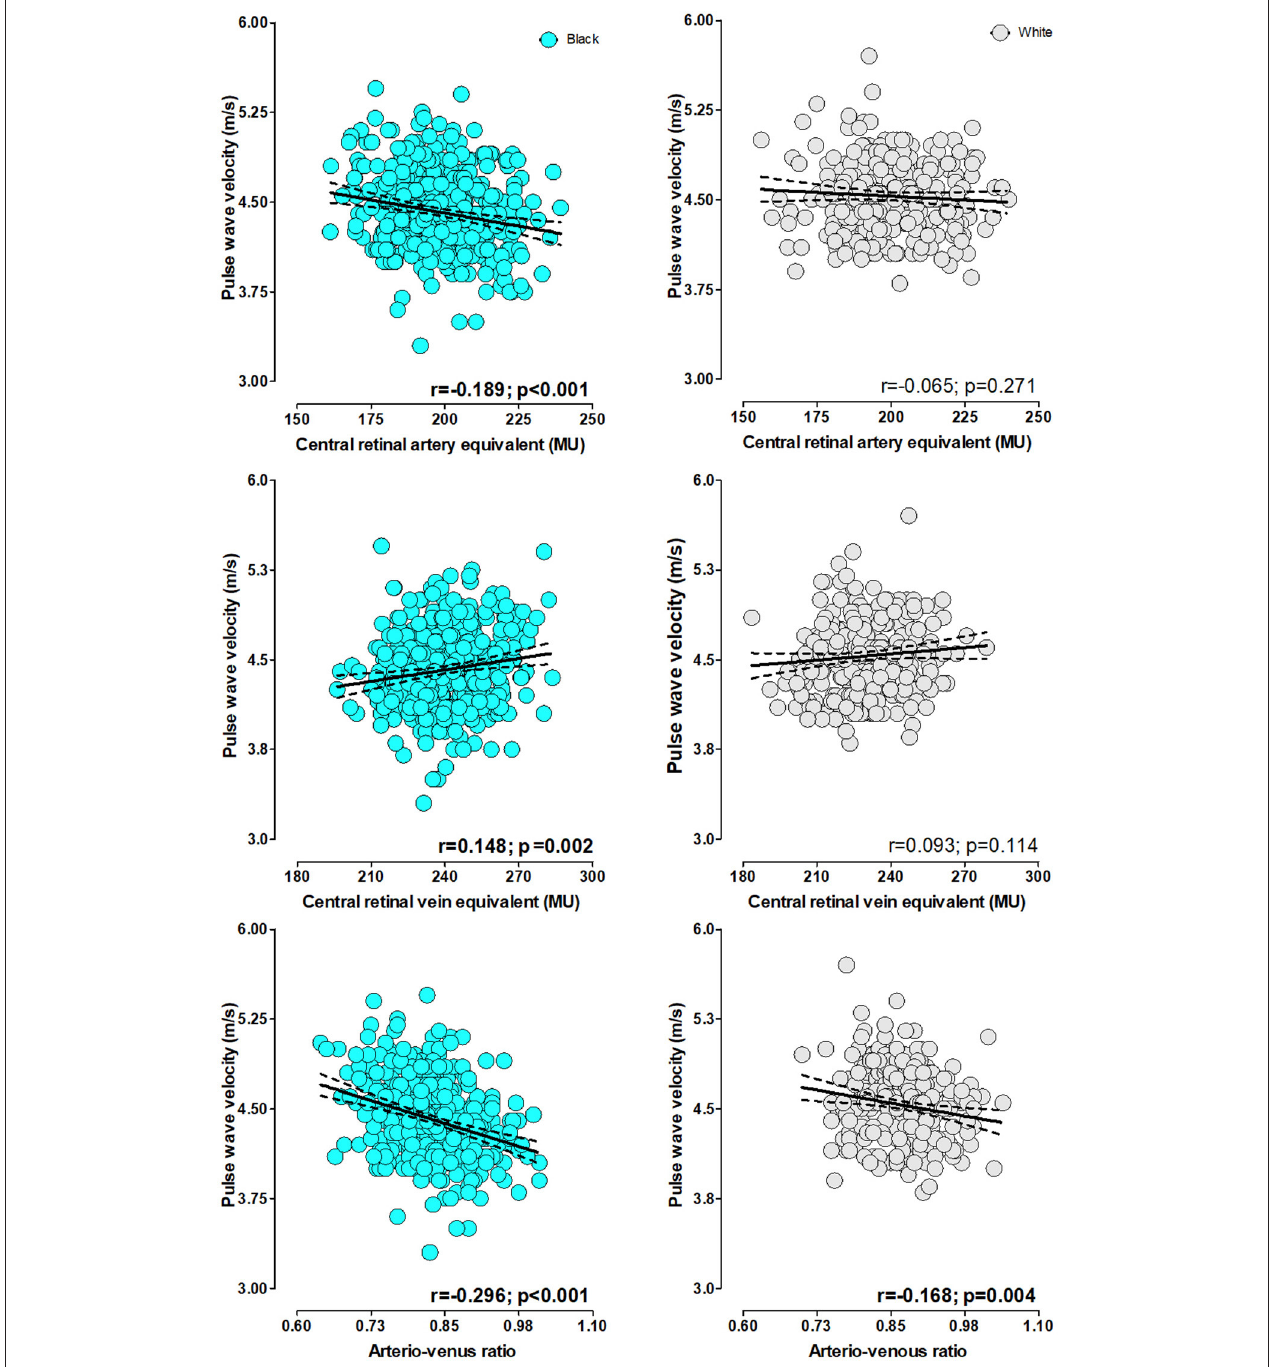
FIGURE 1 | Single regression analyses pulse wave velocity with retinal calibers stratified by